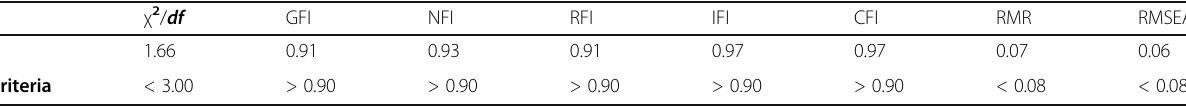
Table 5 Goodness-of-fit index of the structural equation model ( n =